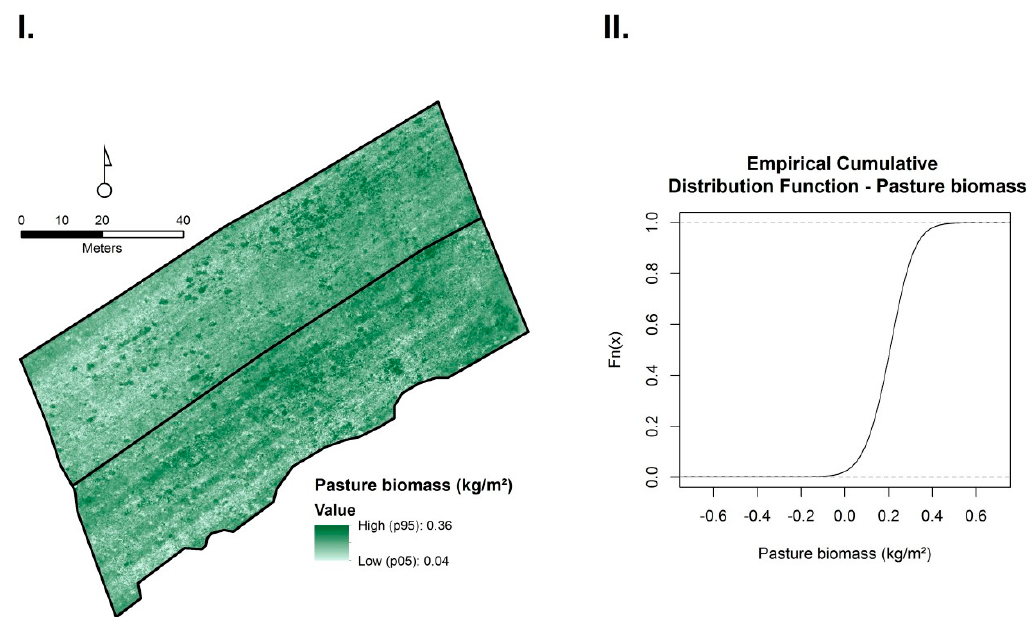
Figure 6. Mapping pasture biomass before grazing using predictors of the best model (Model 4) within pastures P1 and P2 ( I ) and the empirical cumulative distribution function (ECDF) plot of the UAS pasture biomass values ( II ).